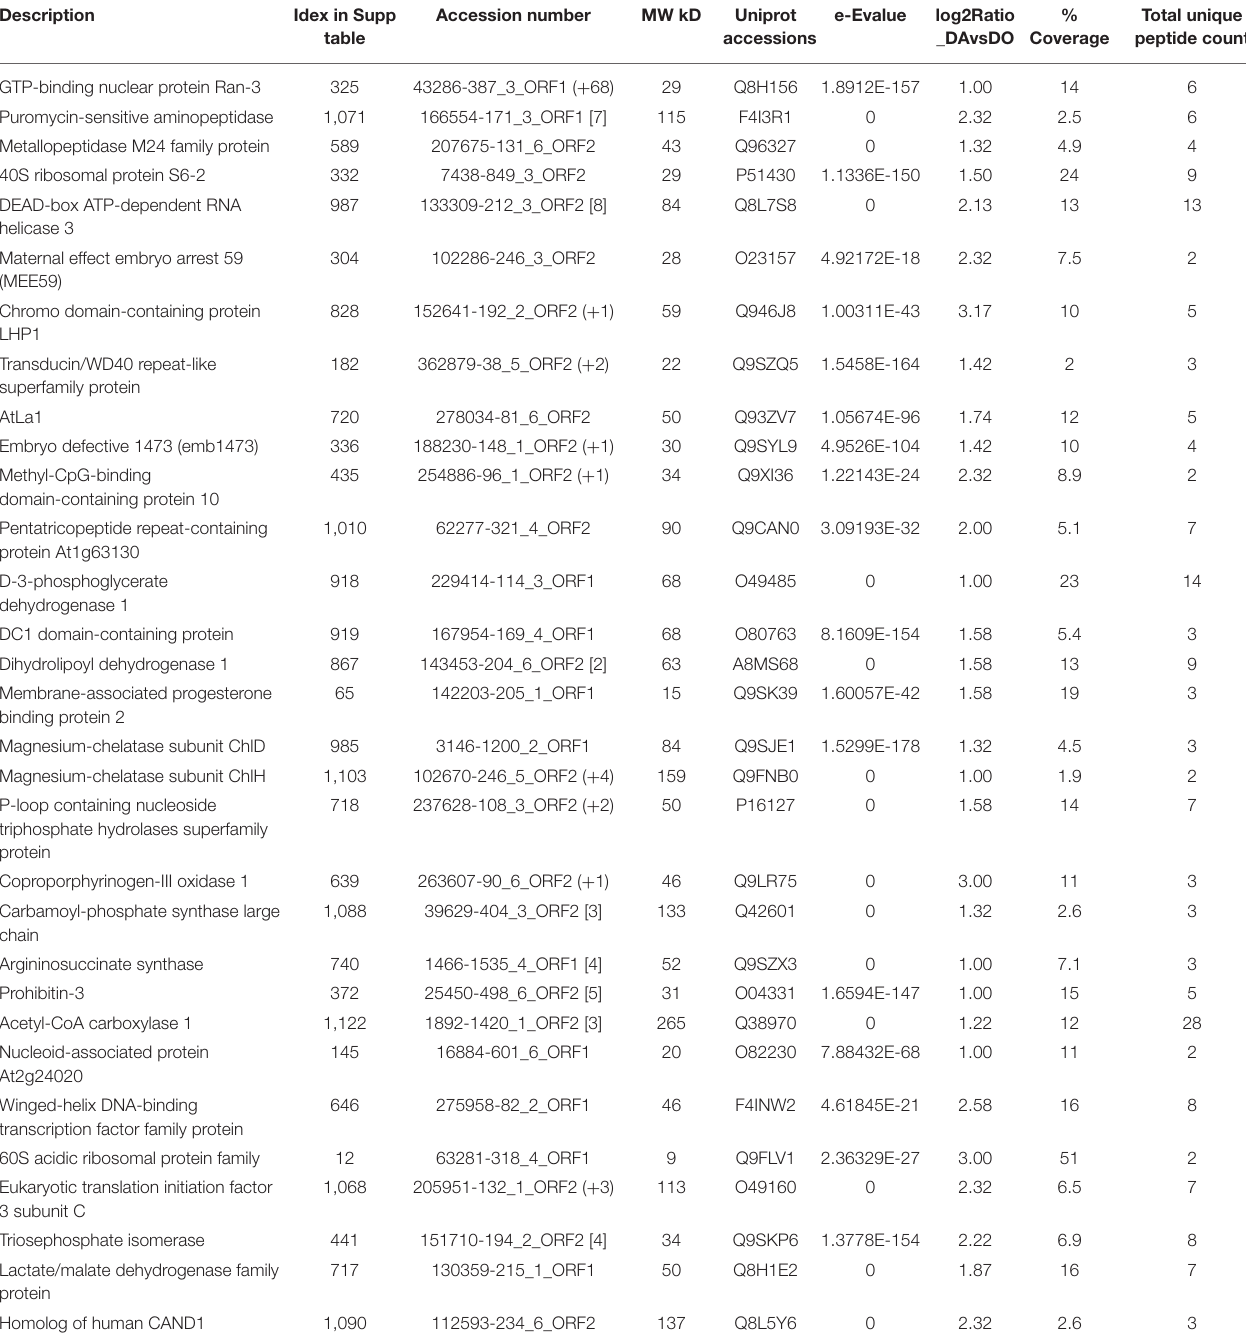
TABLE 1 | Selected proteins upregulated in the apogamous fern Dryopteris affinis ssp. affinis